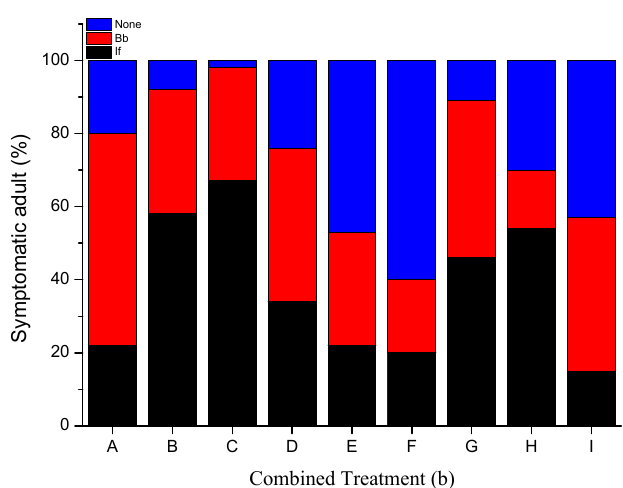
Figure 1. Percent infection attributed to each insect pathogen after the combined inoculation of Hypocreales fungi on the adults of S. granarius ( a ) and S. oryzae ( b ). If— I. fumosorosea ; Bb— B. bassiana .